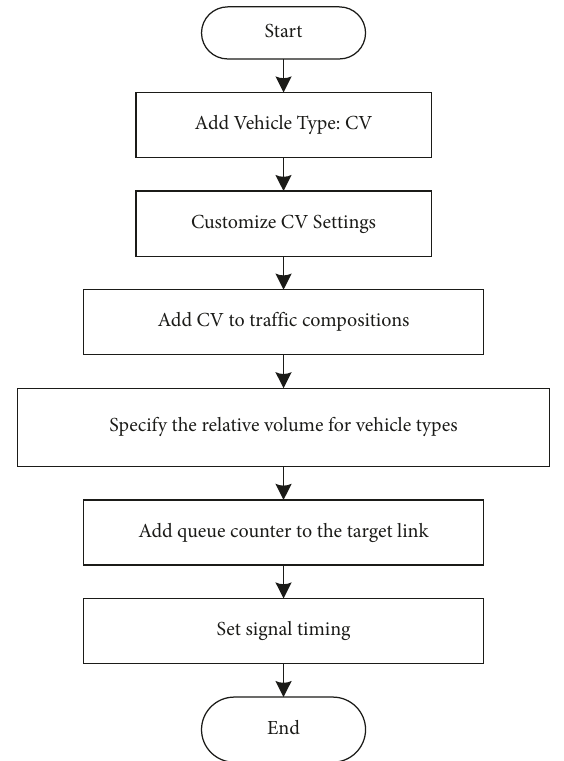
Figure 3: The process of simulation scenarios establishment.